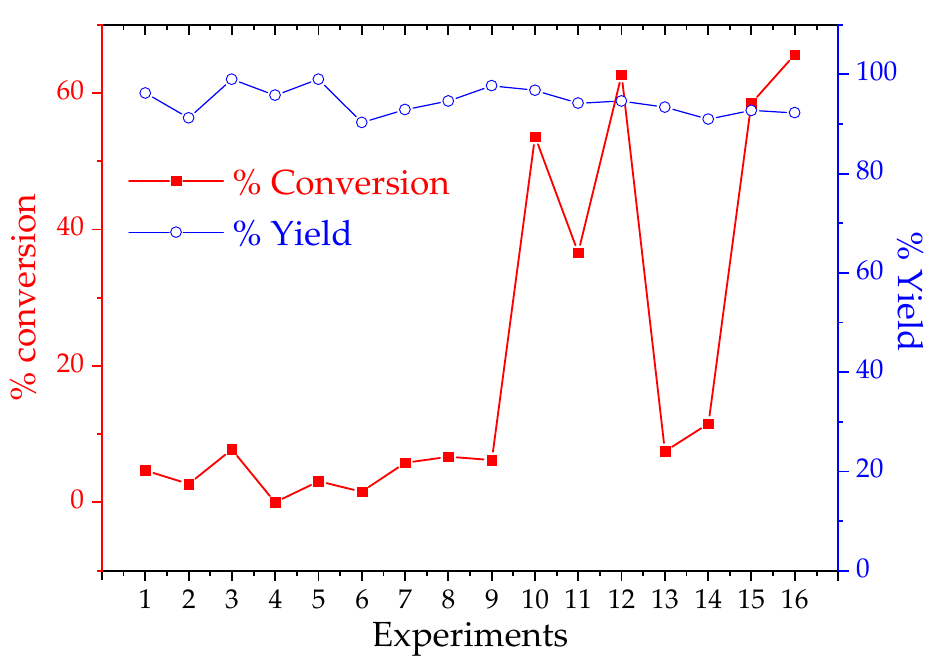
Figure 7. Yield and conversion obtained in a 2 4 factorial planning for biofuel production. Table 8. Synergic analysis of the reaction parameters and its effects in conversion